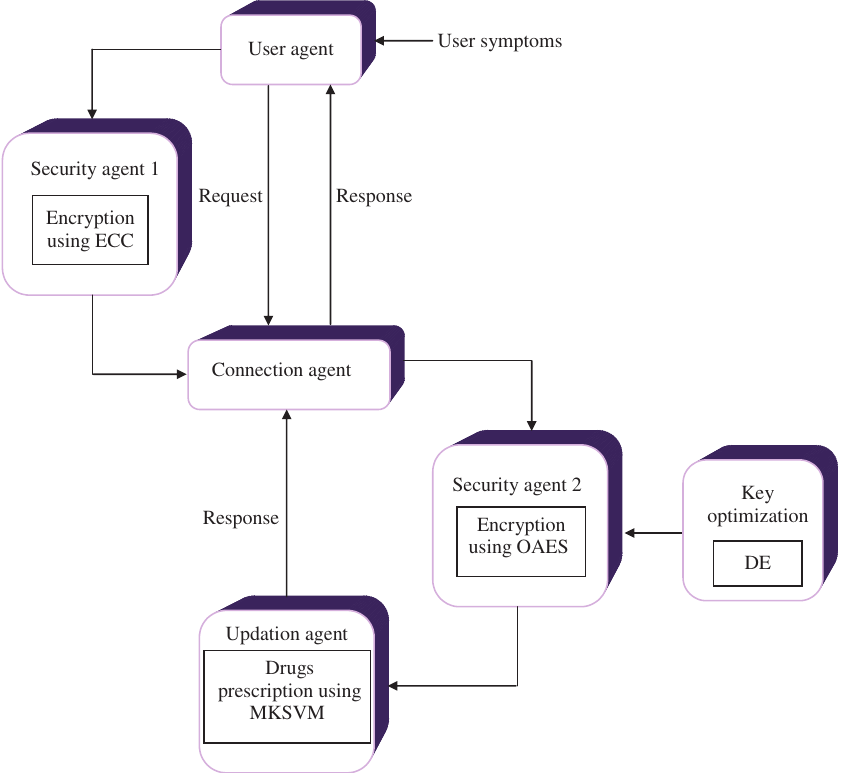
Figure 1: Overall Flow Diagram of the Proposed